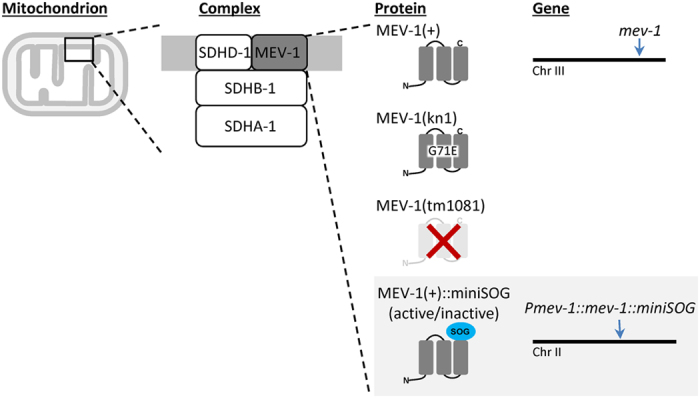
Schematic of how the genetically-encoded photosensitizer miniSOG is used for Chromophore-Assisted Light-Inactivation (CALI) of mitochondrial respiratory chain complex II.The C. elegans gene mev-1 codes for one of four nuclear encoded subunits that comprise mitochondrial complex II, also known as mitochondrial succinate:ubiquinone oxidoreductase (in mammals, this complex is comprised of SDH subunits (A–D). The native mev-1 gene (mev-1(+)) resides on chromosome III as indicated by the arrow. Two mutant alleles were used in this study, mev-1(kn1)III and mev-1(tm1081)III. The kn1 allele contains a G71E point mutation resulting in a strain with a decreased brood size and sensitivity to paraquat11. The tm1081 allele is a deletion that results in a lethal/sterile phenotype. The genetically-encoded photosensitizer miniSOG was inserted into a mev-1 genomic fragment so as to create a fusion tag at the C-terminus, and the synthetic mev-1::minSOG transgene was integrated on chromosome II (arrow) using Mos1-mediated single-copy insertion (MosSCI). Either an active (able to produce ROS in response to light) or inactive (not able to produce ROS) variant of miniSOG was used to account for tagging and expression artifacts. Alleles are abbreviated as follows, mev-1(+)III as “+”, mev-1(kn1)III as “kn1”, mev-1(tm1081)III as “tm1081”, rnySi29 as “inactive”, and rnySi19 as “active”.